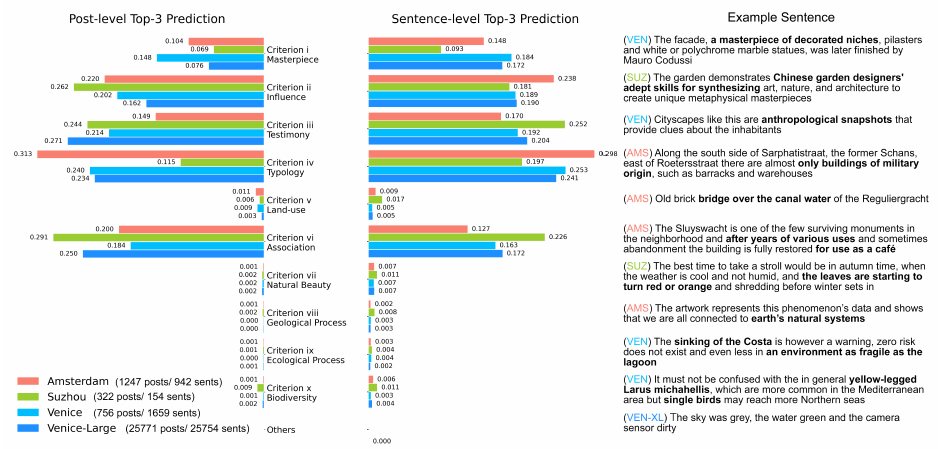
Figure 3. The proportion of posts and sentences that are predicted and labeled as each heritage value (OUV selection criterion) as top-3 predictions by both BERT and ULMFiT. One typical sentence from each category is also given in the right part of the